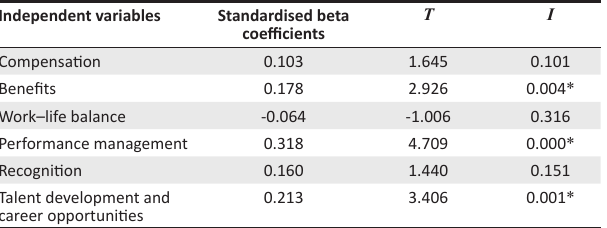
TABLE 4: Contribution of independent variables for predicting organisational commitment.